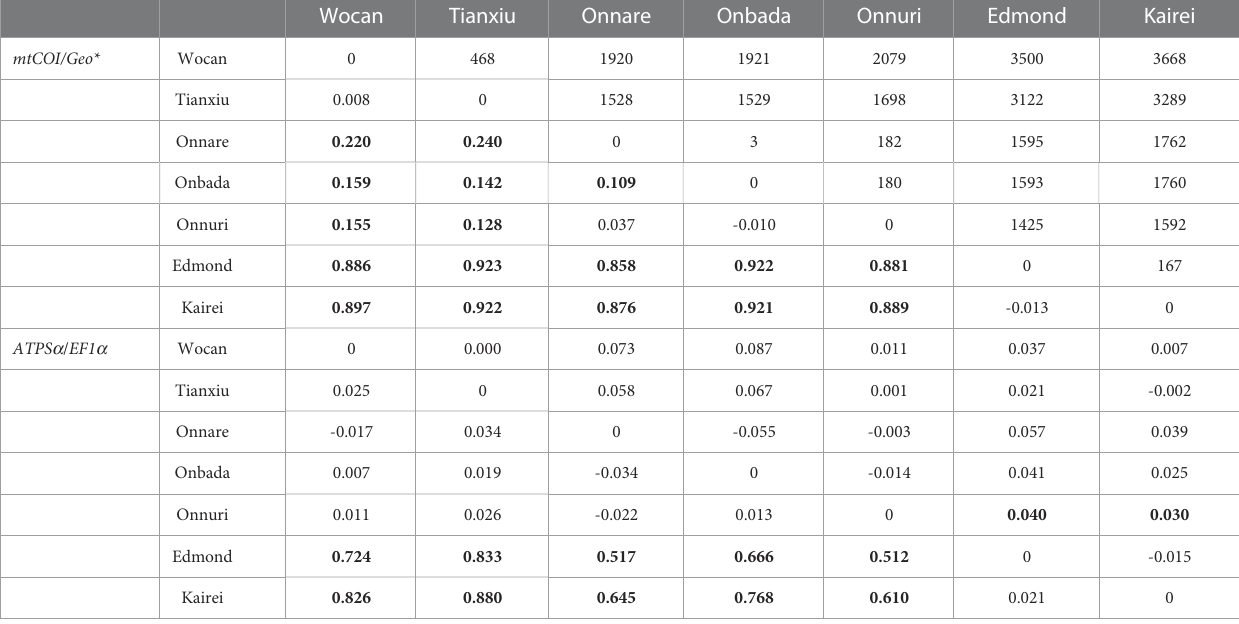
TABLE 4 Geographic distance (Geo) and pairwise genetic differentiation ( F ST ) between vent localities. First listed matrix is below and second matrix is above the